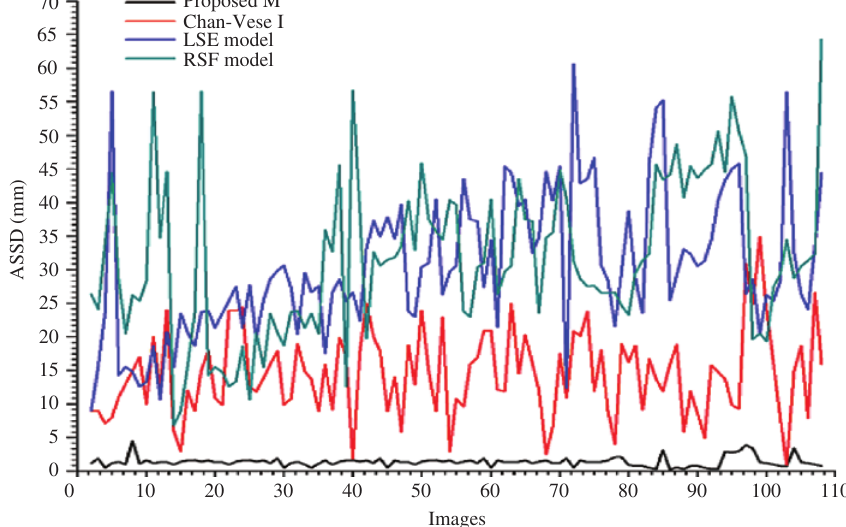
Figure 6: Comparison of Performance Evaluation Results using